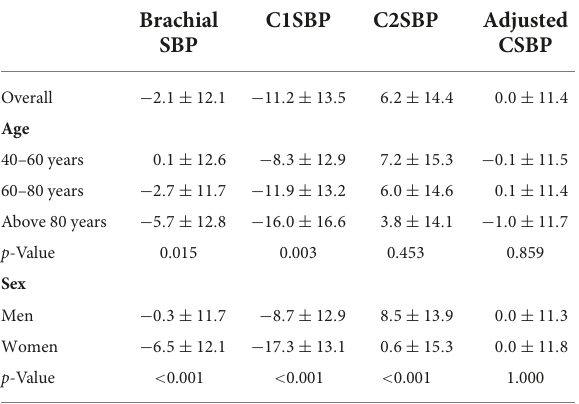
TABLE 2 Differences between estimated and invasive aortic SBP by age and